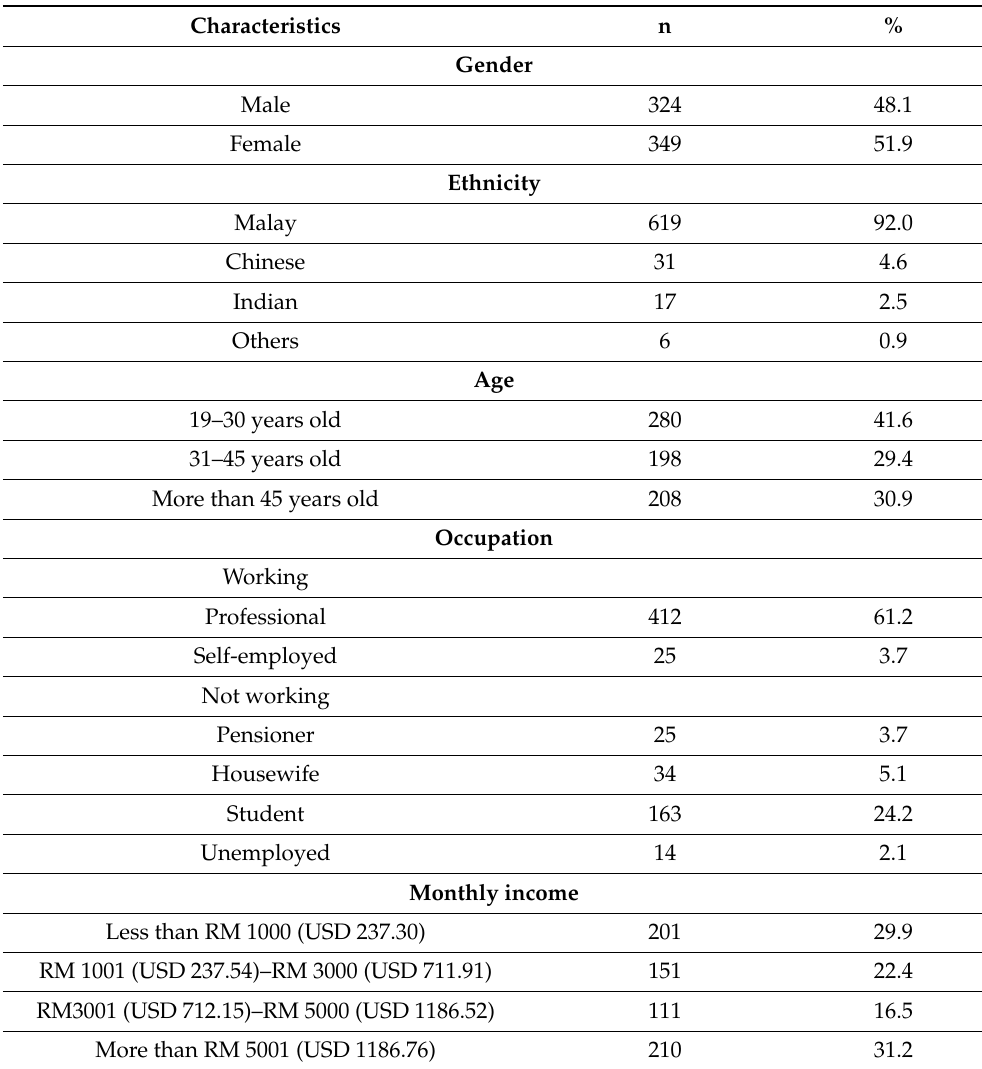
Table 1. Social demographics of consumers (n =